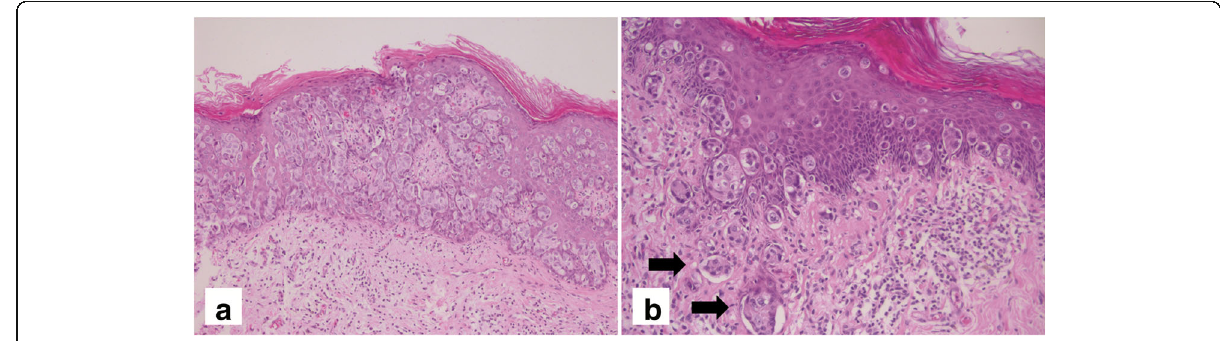
Fig. 1 a , b . Large cells ( “ Paget cells ” ) with pale cytoplasm and large nuclei with prominent nucleoli, arranged either singly or in clusters throughout the epithelium. b . Stromal invasion and lymphovascular space invasion (arrows) are evident (Hematoxylin & eosin; A: original magnification ×200; B: original magnification